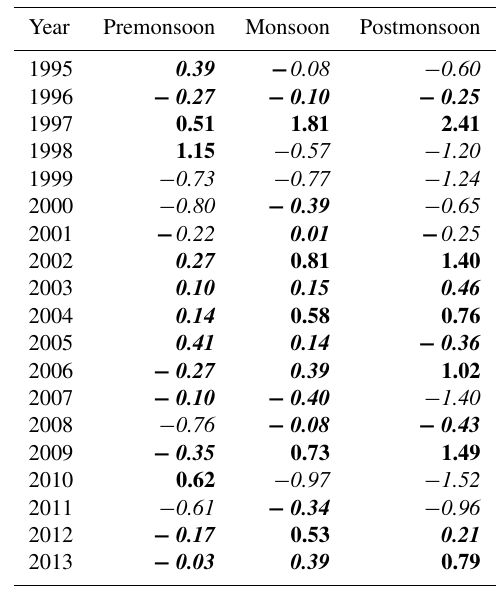
Table 1. ONI during the premonsoon, monsoon and postmonsoon season in India from 1995 to 2013. The bold, italics and bold italic values denote El Niño, La Niña, and neutral phases of ENSO, re-